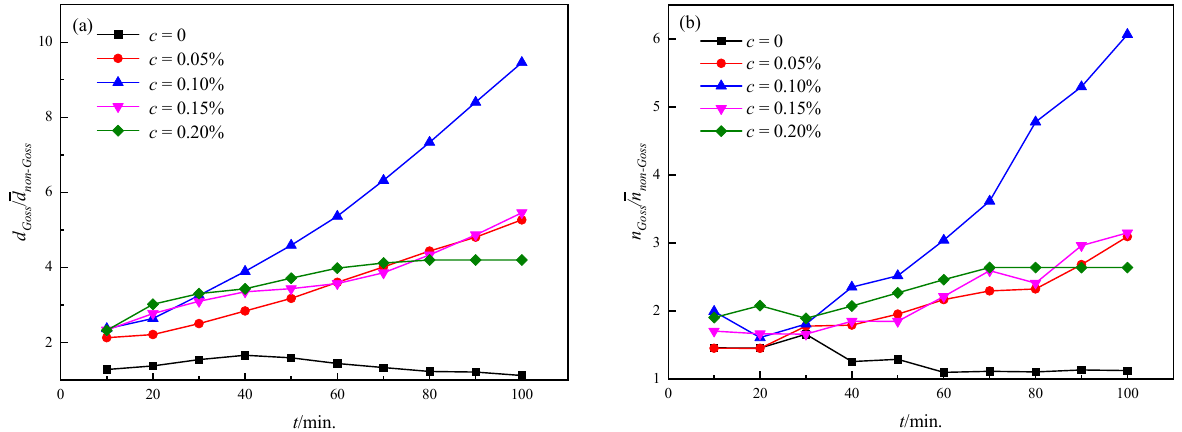
Figure 8. The quantitative characterization of abnormal growth levels under different particle con- tents: ( a ) the size ratio of Goss grains to non-Goss grains; ( b ) the side ratio of Goss grains to non- Goss